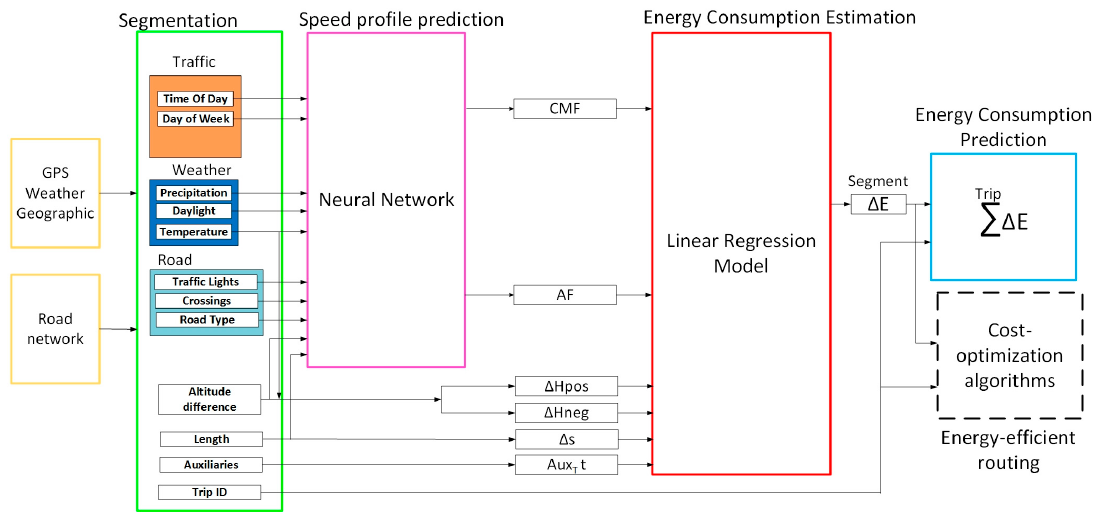
Figure 5. Detailed overview of the proposed model for energy consumption prediction. AF: aerodynamic factor; CMF: constant motion factor.